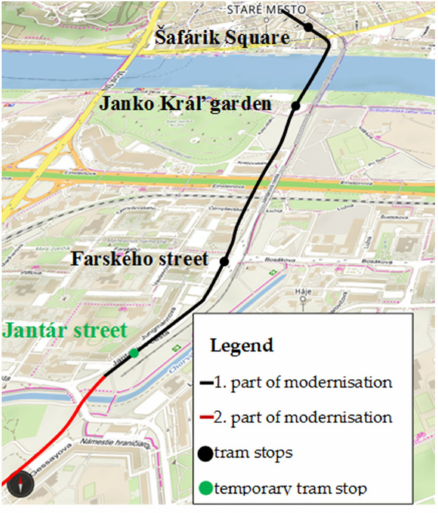
Figure 2. Modernisation of Petržalka radial